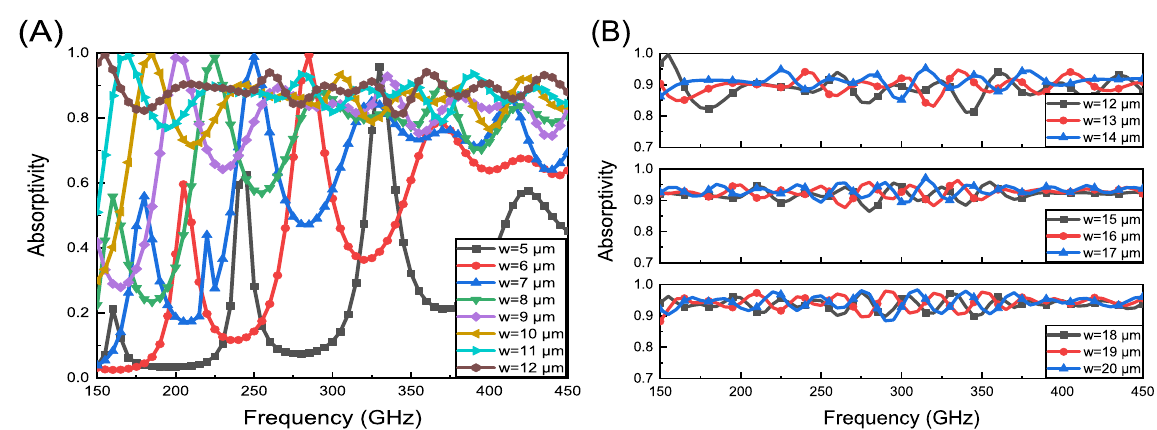
Figure 5. Absorptivity versus frequency with different w: ( A ) w = 5–12 µ m and ( B ) w = 12–20 µ m.